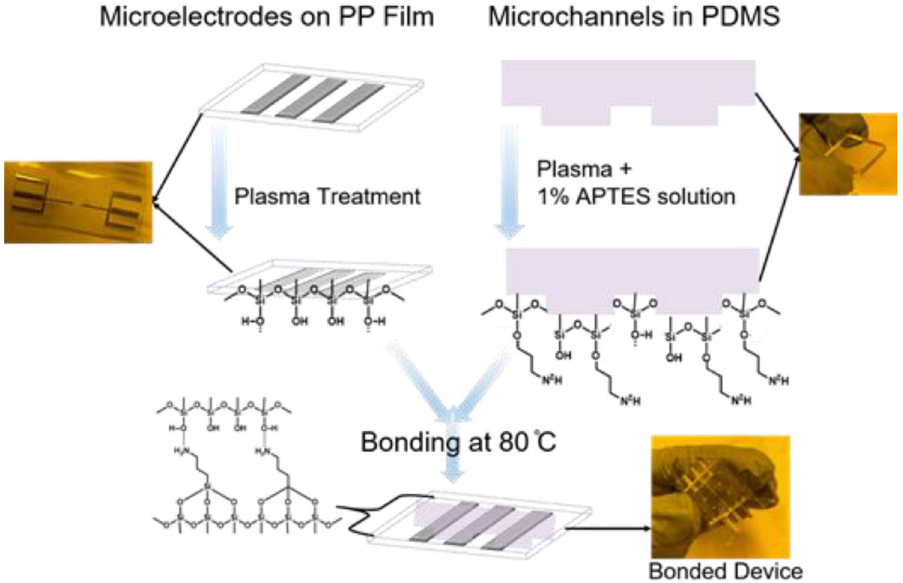
Figure 4. Schematic of the bonding process. An irreversible bonding is formed between microelectrodes patterned polypropylene (PP) film, and microchannels defined